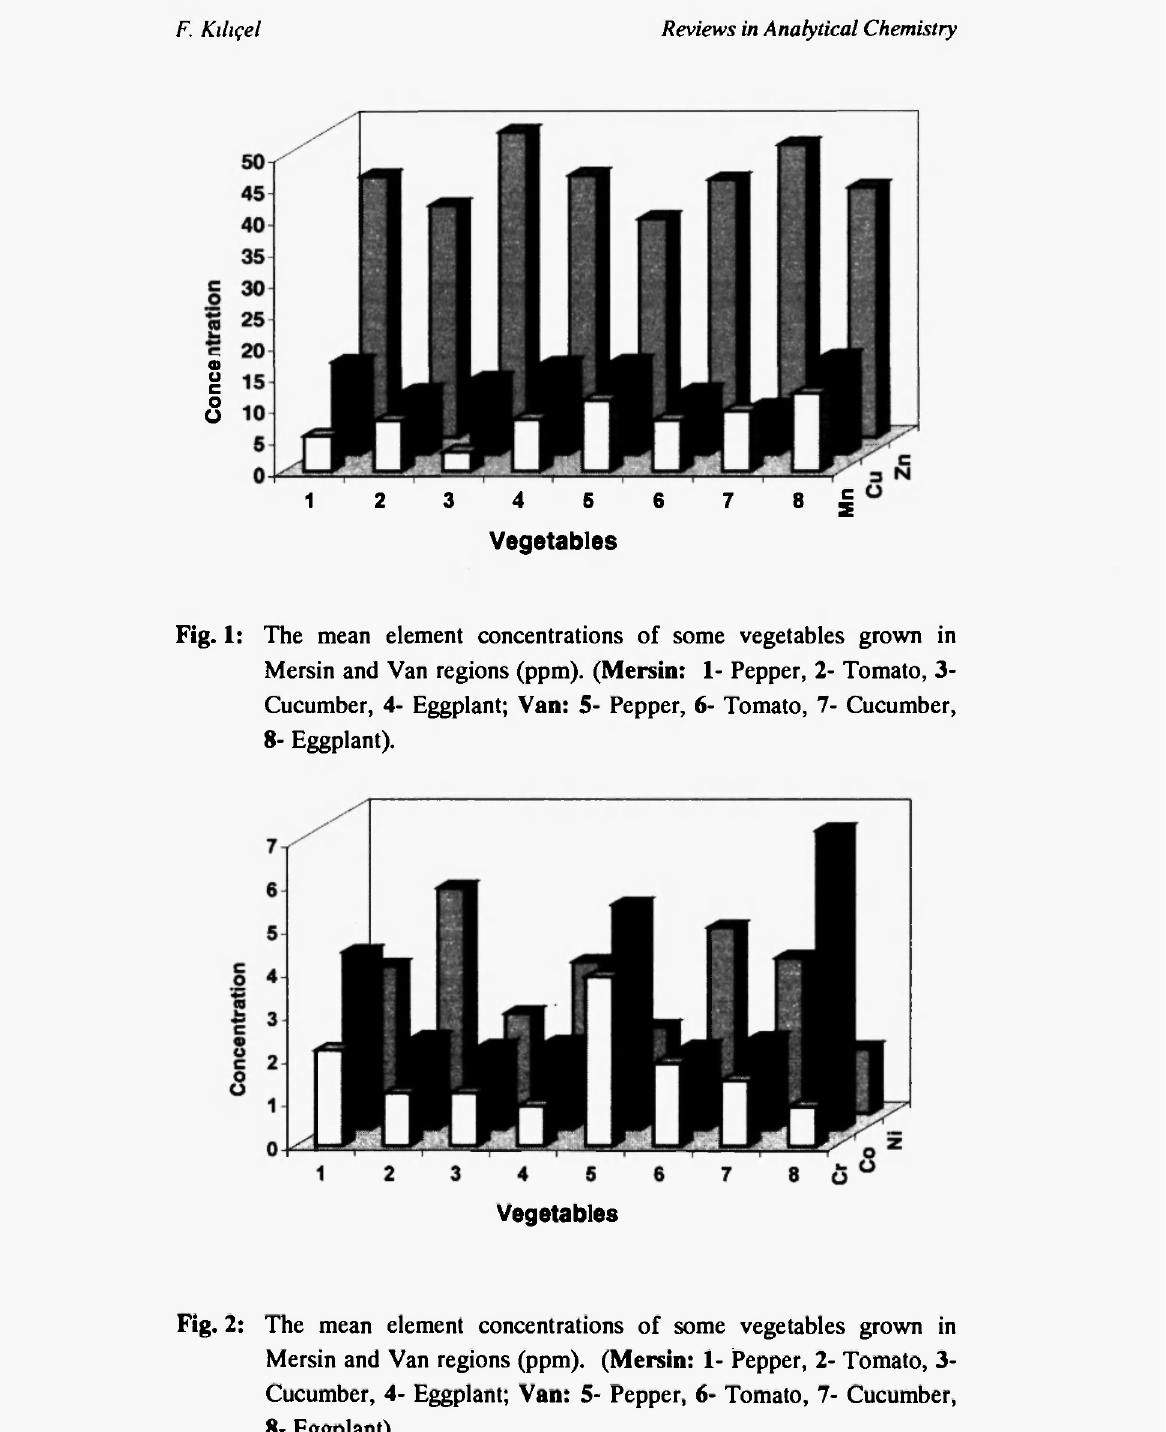
Fig. 2: The mean element concentrations of some vegetables grown in Mersin and Van regions (ppm). (Mersin: 1- Pepper, 2- Tomato, 3- Cucumber, 4- Eggplant; Van: 5- Pepper, 6- Tomato, 7- Cucumber, 8-